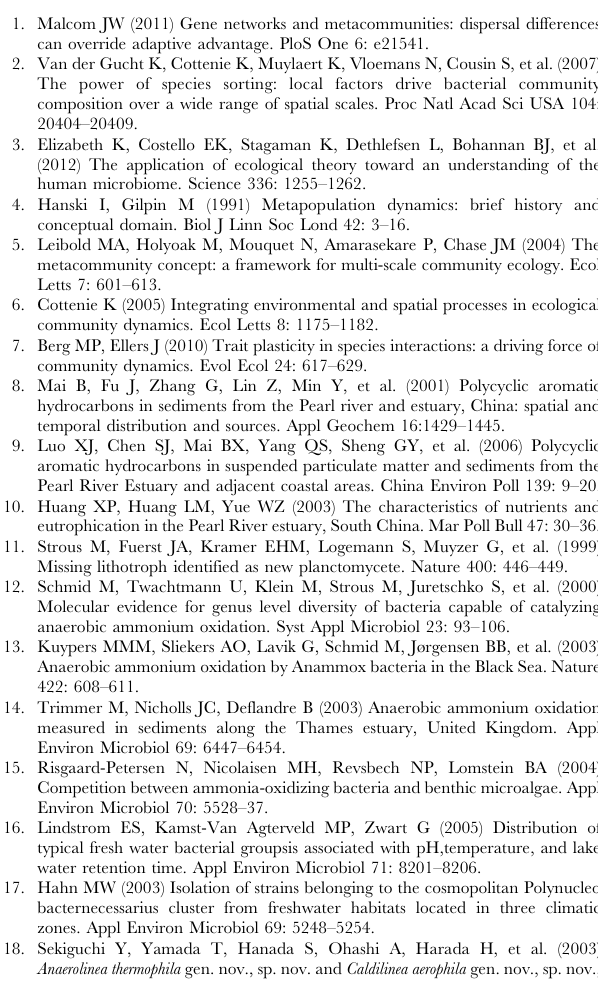
Figure S3 Similarity of microbial communities from the surface sediment and overlying bottom water from the Pearl River Estuary, as illustrated by UPGMA jackknifed hierarchical clustering. Bootstrap values larger than 50% of the 1,000 resamplings are shown at the nodes. See Table 1 and Figure 2 for the sample identifiers. File S1 Contains Table S1, barcoded primers for obtaining 16S rDNA amplicons from the bottom water and surface sediment samples. Table S2, microbial diversity in the bottom water and surface sediments from the Pearl River Estuary in summer and